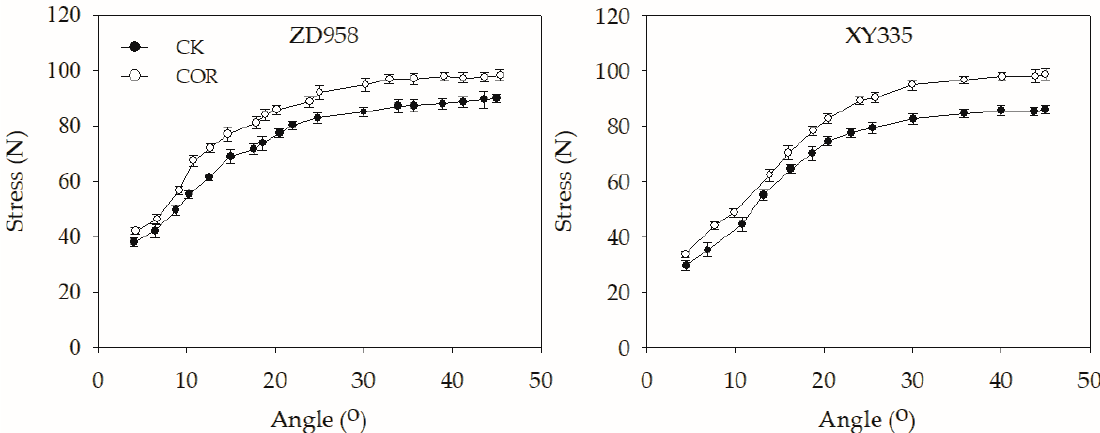
Figure 7. Effects of COR on the pushing resistance of the lower part in ZD958 and XY335 plants in 2018. ZD958: Cultivar “zhengdan958”; XY335: cultivar “Xanyu335”; CK: control treatment; COR10: 10 µmol L -1 COR treatment.